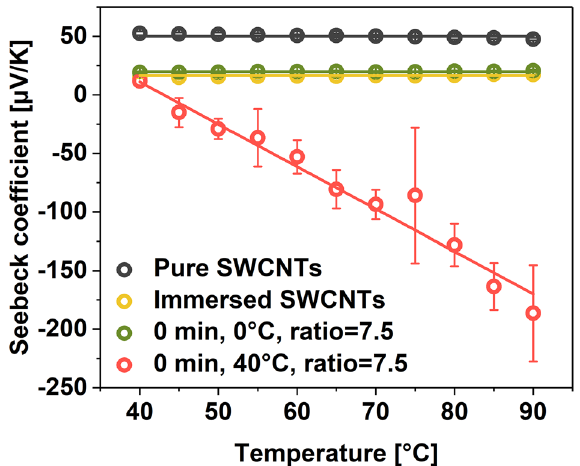
Figure 8. Seebeck coefficient of the described SWCNT